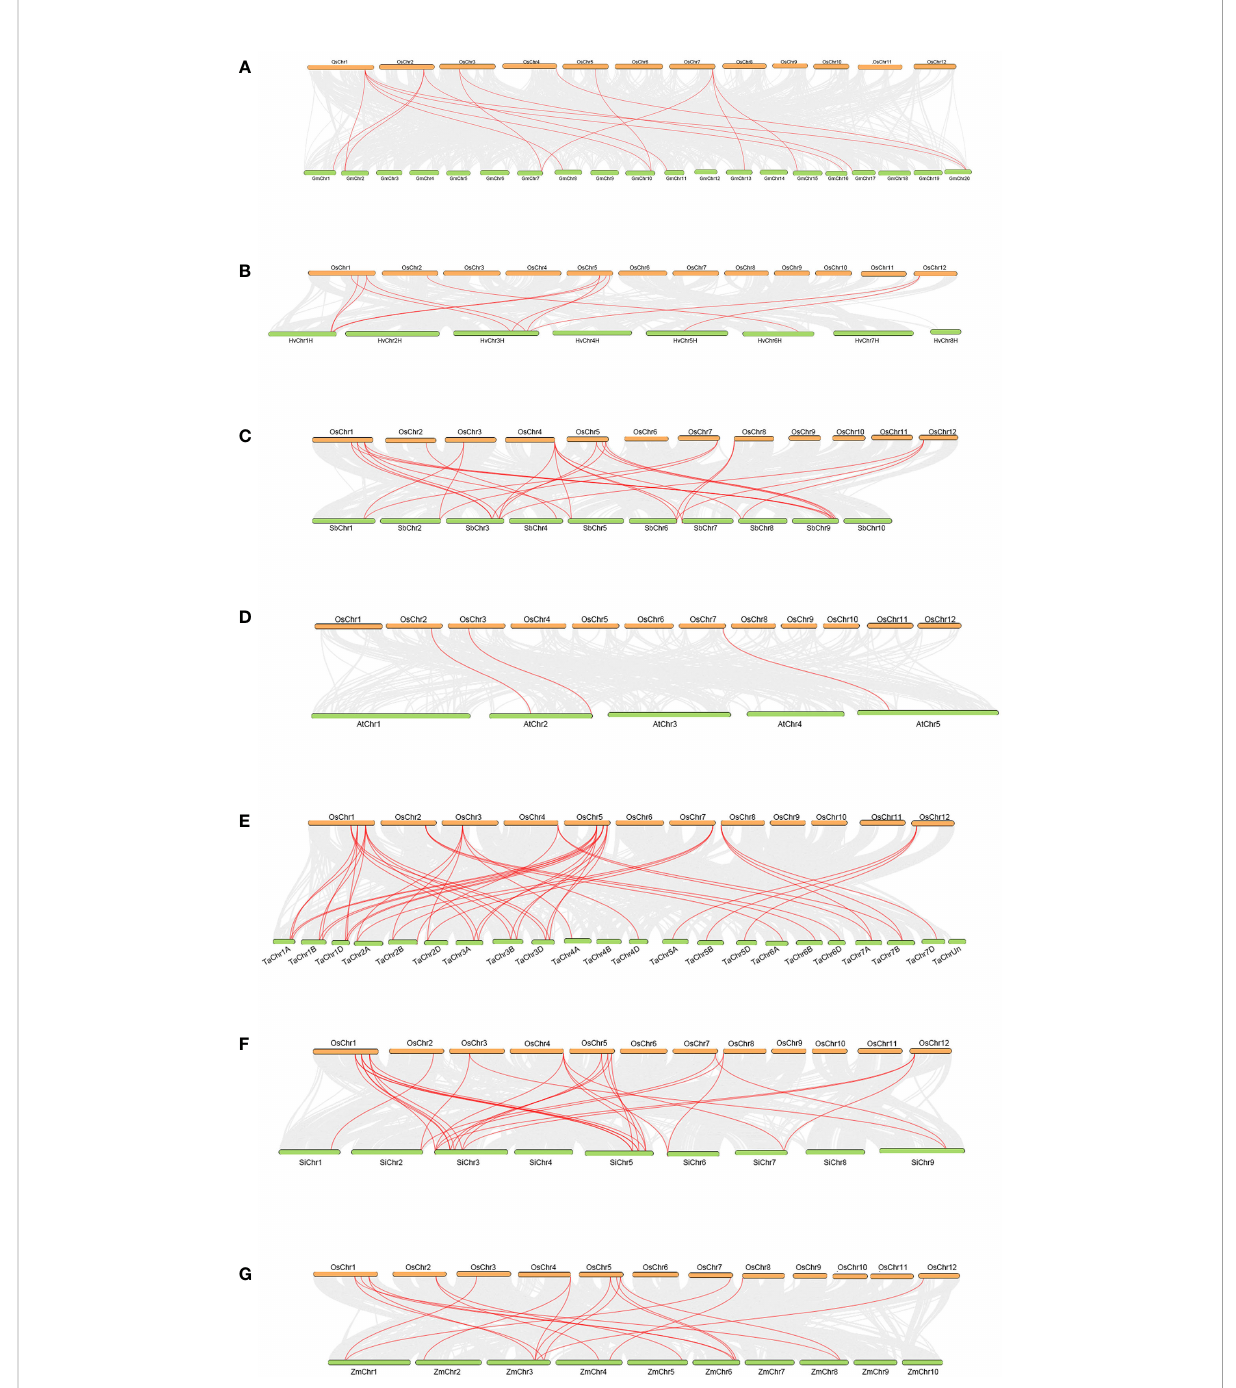
FIGURE 4 Collinearity between OsTLPs and TLPs from other seven species. O.sativa vs G.max (A) , O.sativa vs H vulgare (B) , O.sativa vs S.bicolor (C) , O.sativa vs (A) thaliana (D) , O.sativa vs T.aestivum (E) , O.sativa vs S.italic (F) , and O.sativa vs Z.mays (G) . The grey lines represent background which indicated the collinear blocks within the genomes of O. sativa and other species, TLP pairs were marked by red